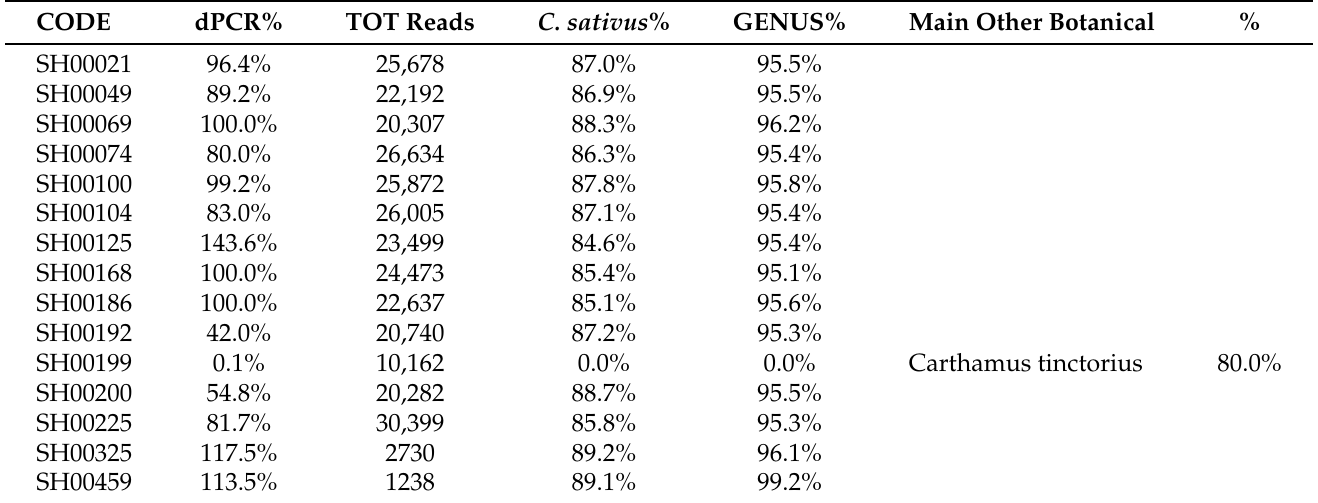
Table A3. Overview of the main metabarcoding results. For each sample the table lists: the total number of reads attributed to plants, the percentage reads attributed to Crocus sativus , the percentage reads attribute tot the Crocus genus (this includes reads attributed to: C. sativus, C. cartwrightianus, C. thomasii, C. pallasii, and to Crocus spp.), the main other botanical found, and its percentage